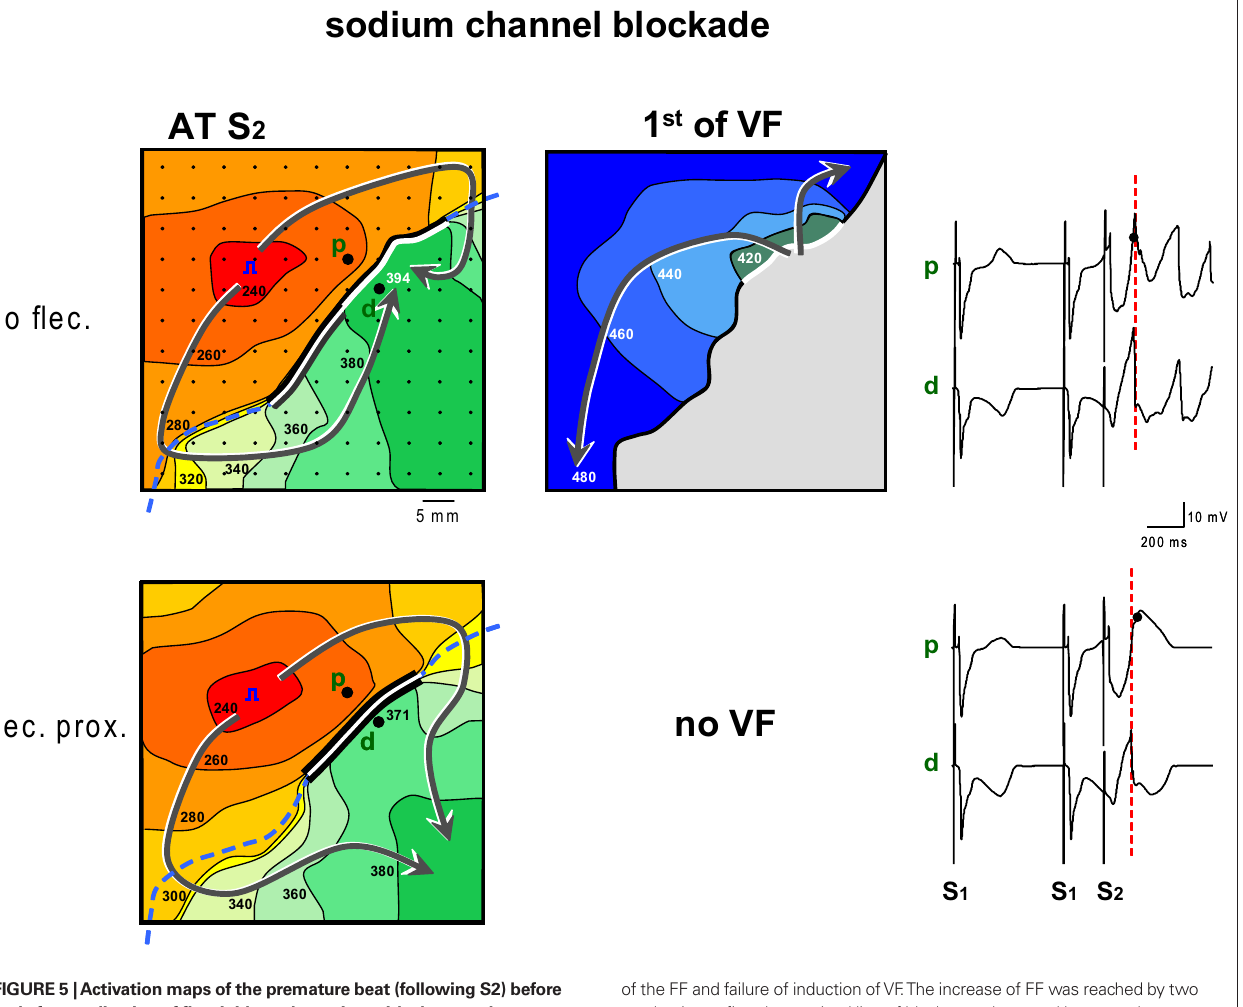
Figure 5 | Activation maps of the premature beat (following S2) before and after application of flecainide to the region with shortened repolarization (proximal). Prior to infusion of flecainide (flec) VF could be induced, because local distal activation coincided with local proximal repolarization. Flecainide infusion into the proximal domain caused an increase